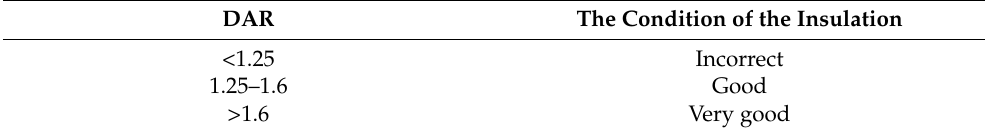
Table 3. Dependence of the absorption coefficient DAR on the condition of the insulation system.